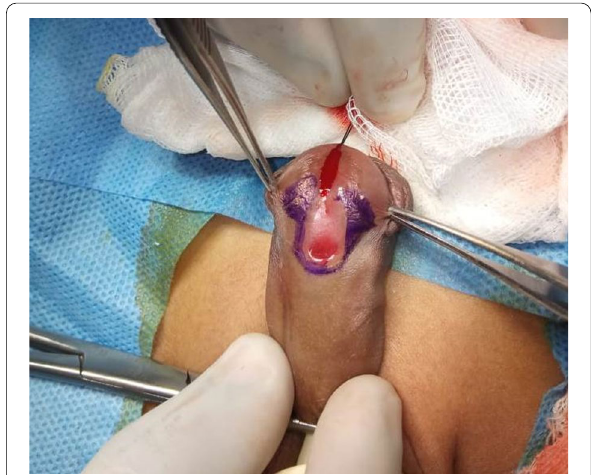
Fig. 1 Periurethral incision and periurethral triangles are marked